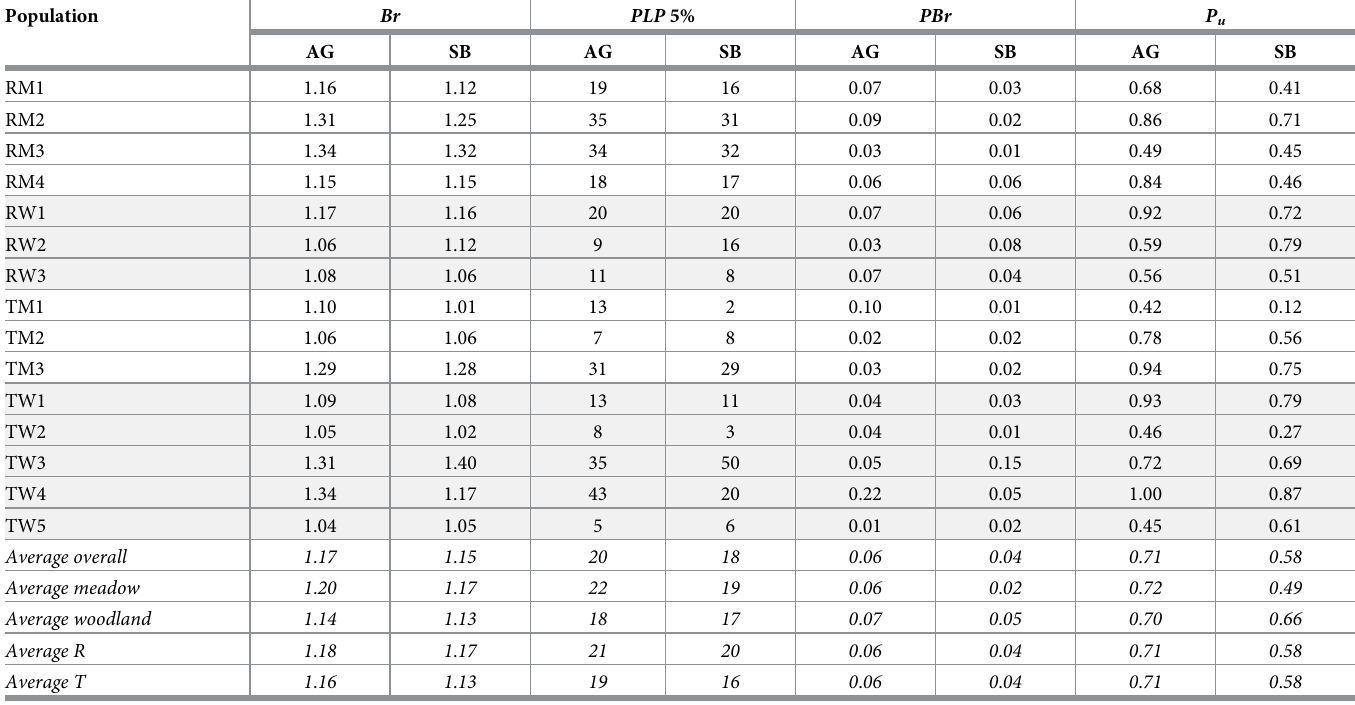
Table 2. Measures of within-population diversity of Viola elatior for aboveground and seed bank individuals. Population